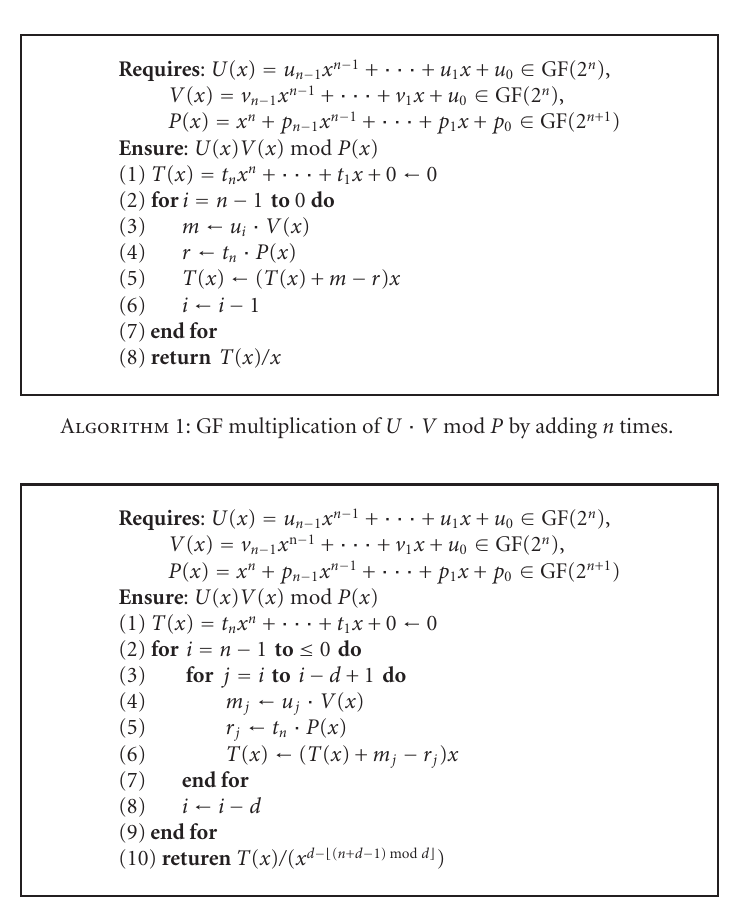
Algorithm 2: GF multiplication of U · V mod P by adding (cid:4) ( n + d − 1) /d (cid:5)